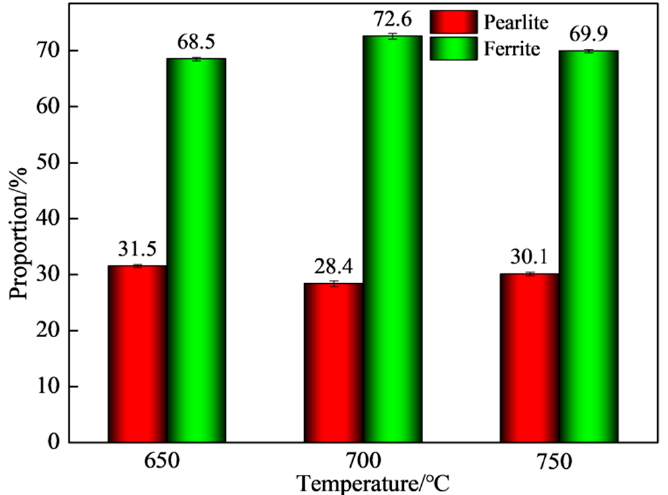
Figure 4. Proportion of ferrite and pearlite in the experimental steel.